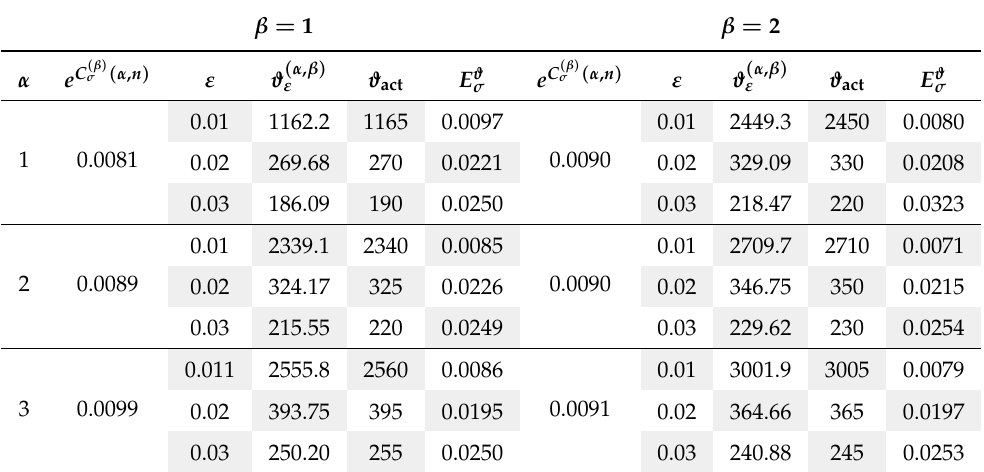
Table 7. Values returned by validation of the Uncertainty Quantification (UQ) rule on DFN202 ( n = 202, σ =